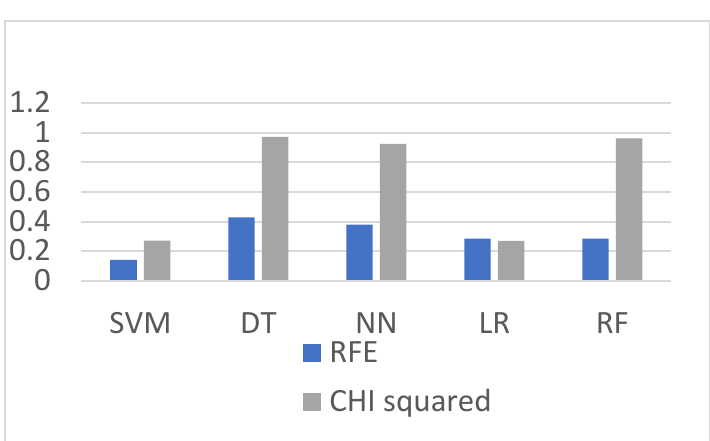
Figure 20. Precision using active risk model.